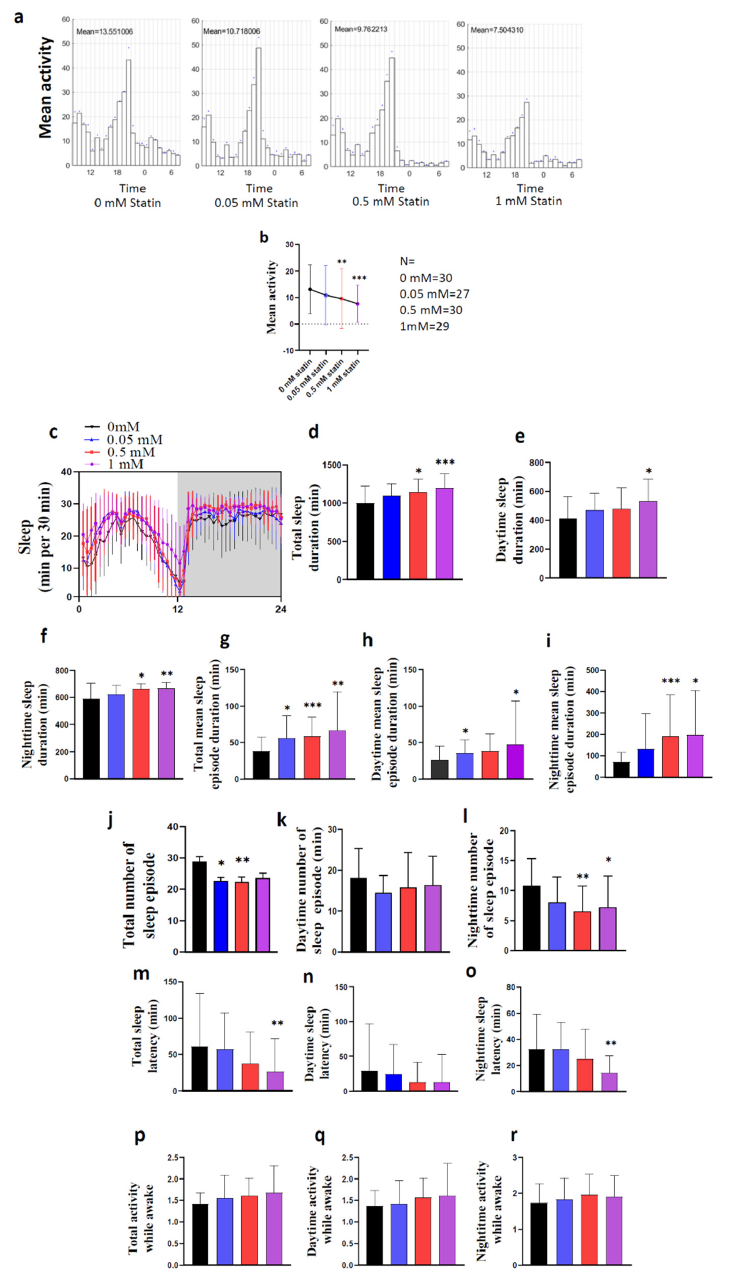
Figure 3. Fluvastatin significantly increases sleep due to increasing episode duration and shortening sleep latency. ( a – c ) Activity and sleep data demonstrate the effect of various fluvastatin concentrations on wild-type male flies; this result is for the first day the flies were treated with fluvastatin. The average activity and sleep per 30 min in groups of flies fed with water (black = 0 mM, n = 30) or fluvastatin: 0.05 mM (blue, n = 27), 0.5 mM (red, n = 30), 1 mM (pink, n = 29), during 12:12 light and dark periods. ( d – r ) Total sleep duration, sleep episode duration, the number of sleep episodes, sleep latency, and activity while awake. All measurements are calculated from the number of beam crossings per minute. The results with error bars indicate mean ± S.D. To detect the significant difference between groups a Shapiro–Wilk test was performed to determine normality, then a one-way ANOVA and Bonferroni post hoc test was performed. * p < 0.01, ** p < 0.001, *** p <